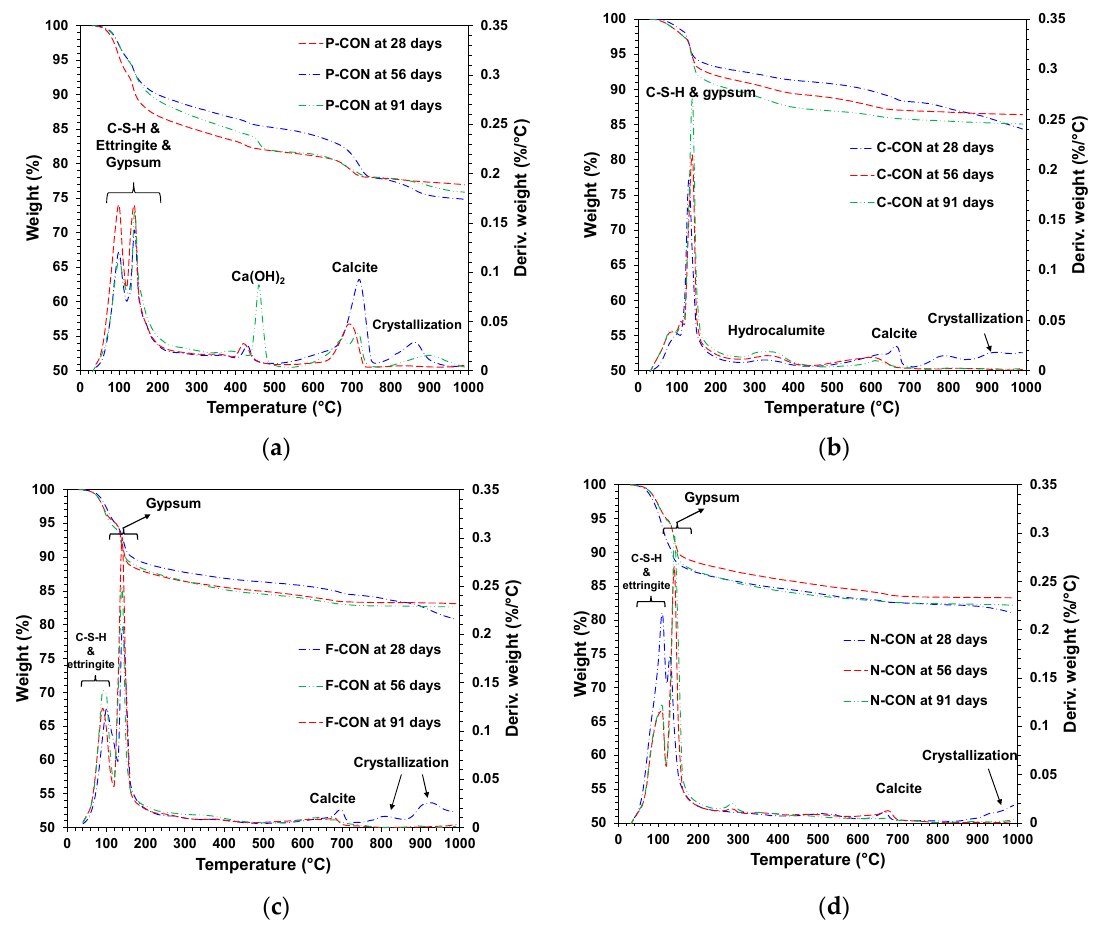
Figure 11. TG/DTG curves of hardened samples immersed in 5% H 2 SO 4 solution: ( a ) P-CON, ( b ) C-CON, ( c ) F-CON, and ( d ) N-CON.